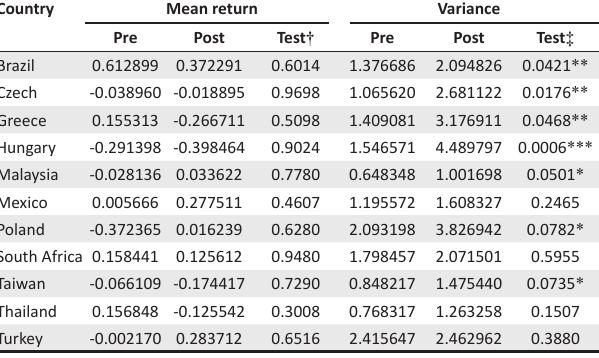
TABLE 5: Results of equality tests.